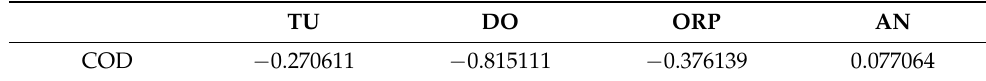
Table 1. Correlation coefficients of item 1.